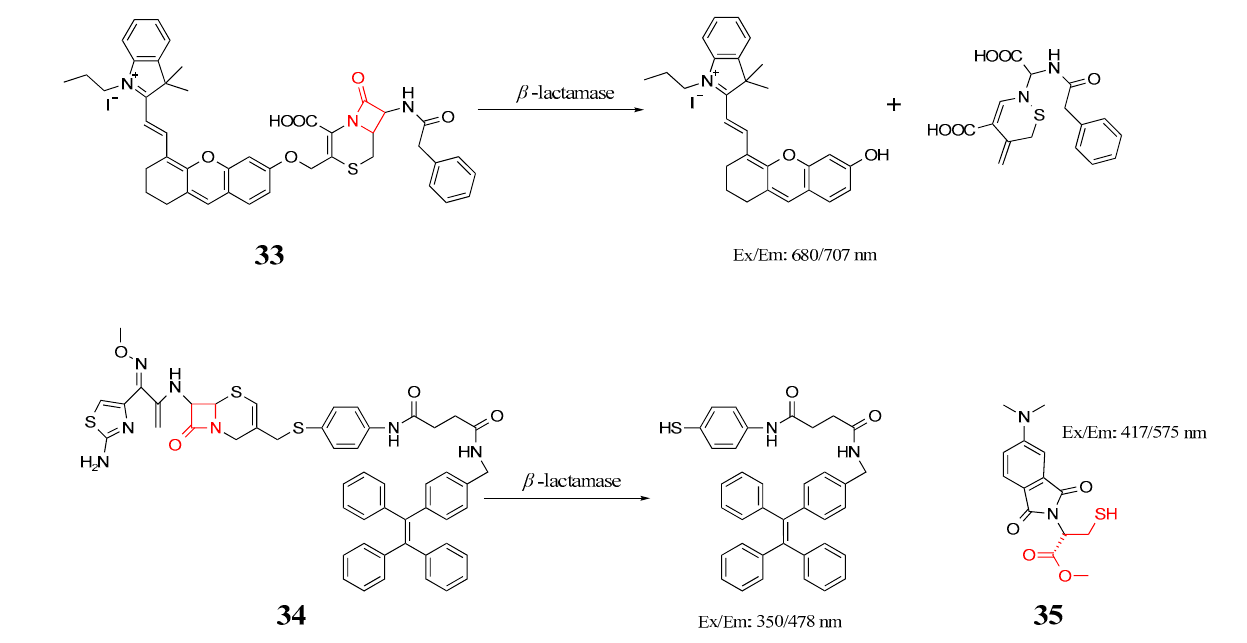
Figure 18. Structure and identification mechanisms of probes 33 – 35 .